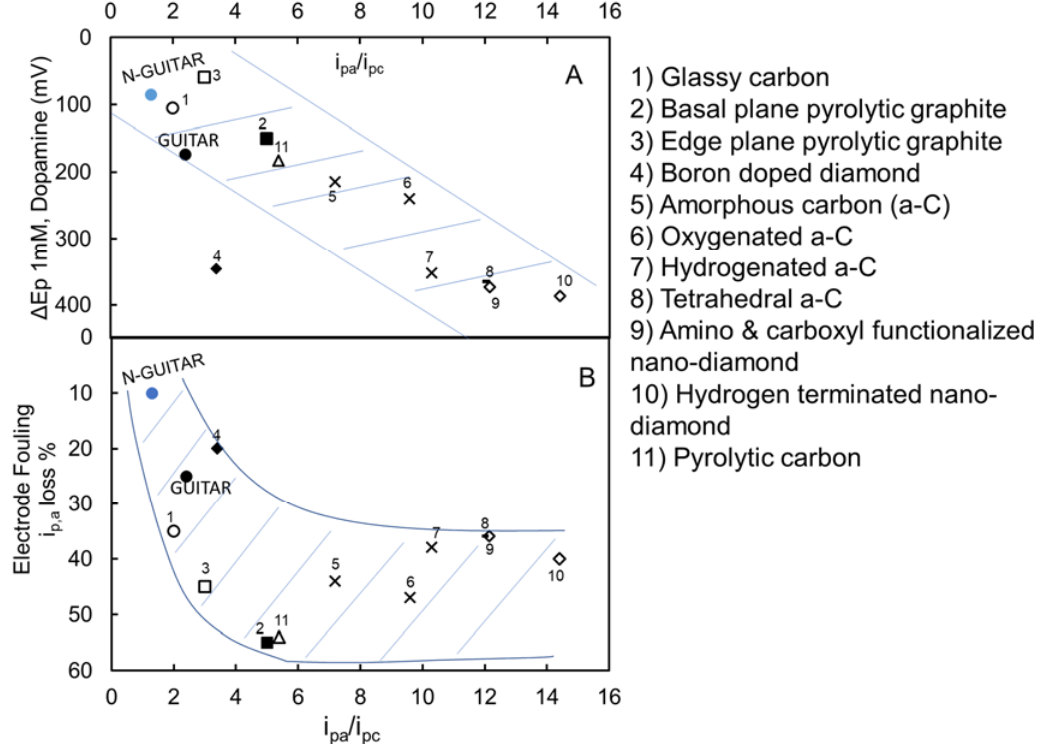
Figure 11. The cyclic voltammetric trends regarding HET kinetics of Step 1 in Figure 10. N ‐ GUITAR and GUITAR as well as literature data were recorded in 1 mM DA at pH 7 phosphate buffer solutions [17–19]. The i p,a /i p,c ratio indicates the reversibility of Step 1 and electrode fouling through loss of i p,a. ( A ) Plot of i p,a /i p,c vs. Δ Ep for N ‐ GUITAR, GUITAR and literature carbon. It is clear that a trend forms with fast HET kinetics (narrow Δ Ep) and lower i p,a /i p,c. ( B ) Electrode fouling through i p,a loss vs. i p,a /i p,c after 10 cycles. The trends are in the shaded region and show that N ‐ GUITAR has the fastest HET rate ( A ) with the least amount of electrode fouling ( B